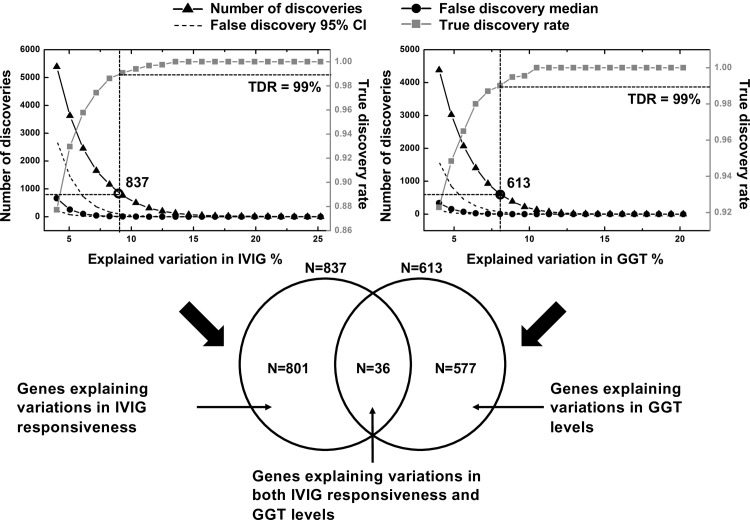
R2 statistic and FDR analyses with respect to GGT levels and IVIG responsiveness.Top left panel: discovery of genes explaining variations in IVIG responsiveness. Top right panel: discovery of genes explaining variations in GGT levels. Bottom panel: Venn diagram analysis uncovering genes explaining variations in both IVIG responsiveness and GGT levels.